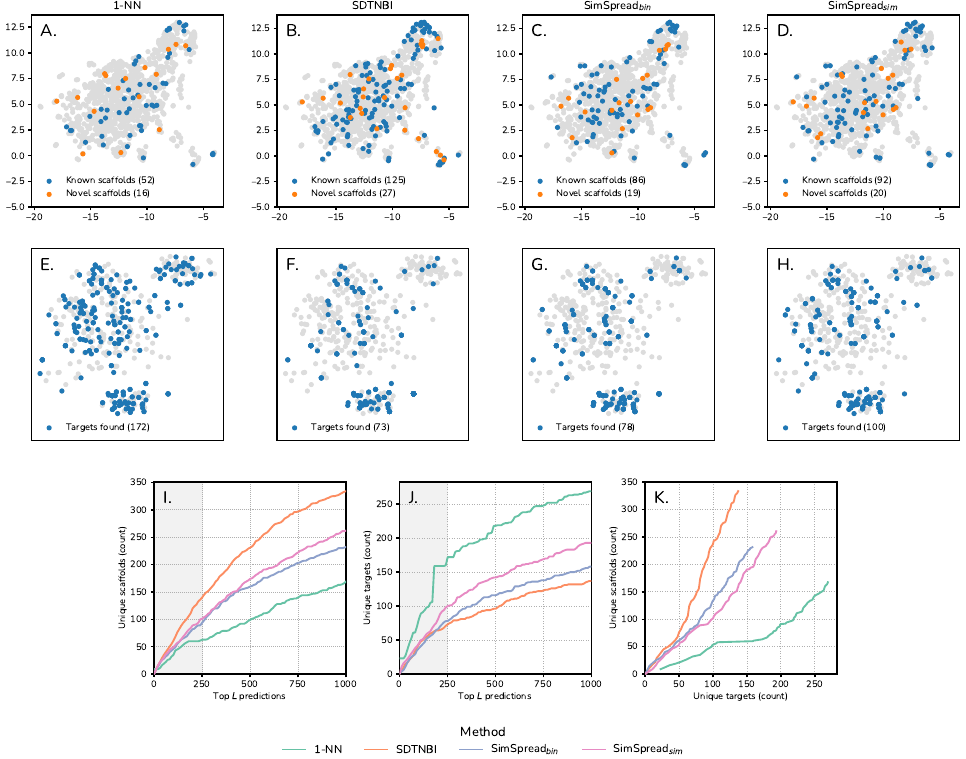
Figure 5. Chemical and biological space exploration. ( A – D ) Molecular scaffolds and ( E – H ) bi- ological targets found in the best 250 predictions obtained in the time-split validation over the ChEMBL24 → 28 dataset using ECFP4 molecular descriptor for 1-NN, SDTNBI, SimSpread bin and SimSpread sim . ( I – J ) Quantification and ( K ) relationship of the number of unique scaffolds and unique targets found in the best 1000 predictions for the previously mentioned methods and SimSpread bin . The shadowed areas in panels I and J correspond to the predictions shown in panels A through D and E through H , respectively. The 2D projection of the chemical space was calculated with UMAP over the ECFP4 molecular descriptors of Murcko scaffolds and the 2D projection of the target space was obtained with UMAP over the GO terms of the biological